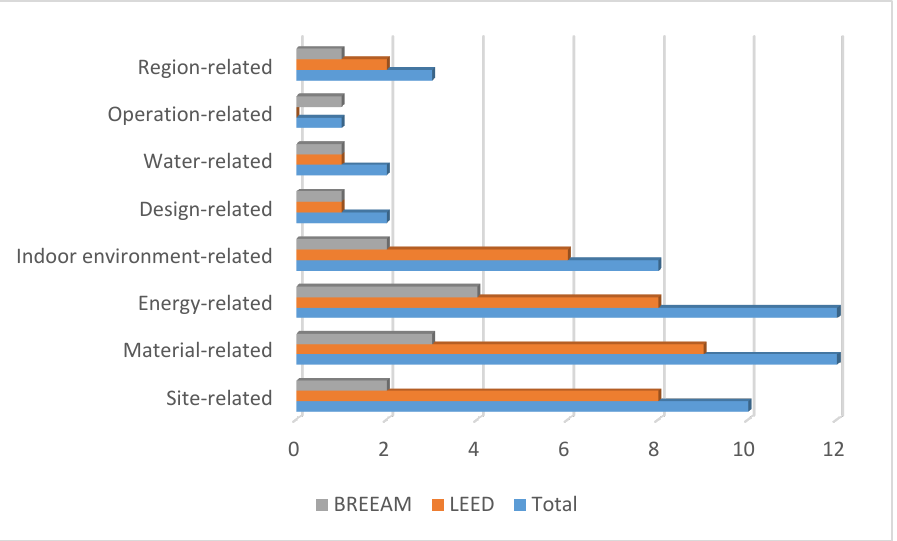
Figure 10. Commonly assessed categories (BREEAM and LEED).